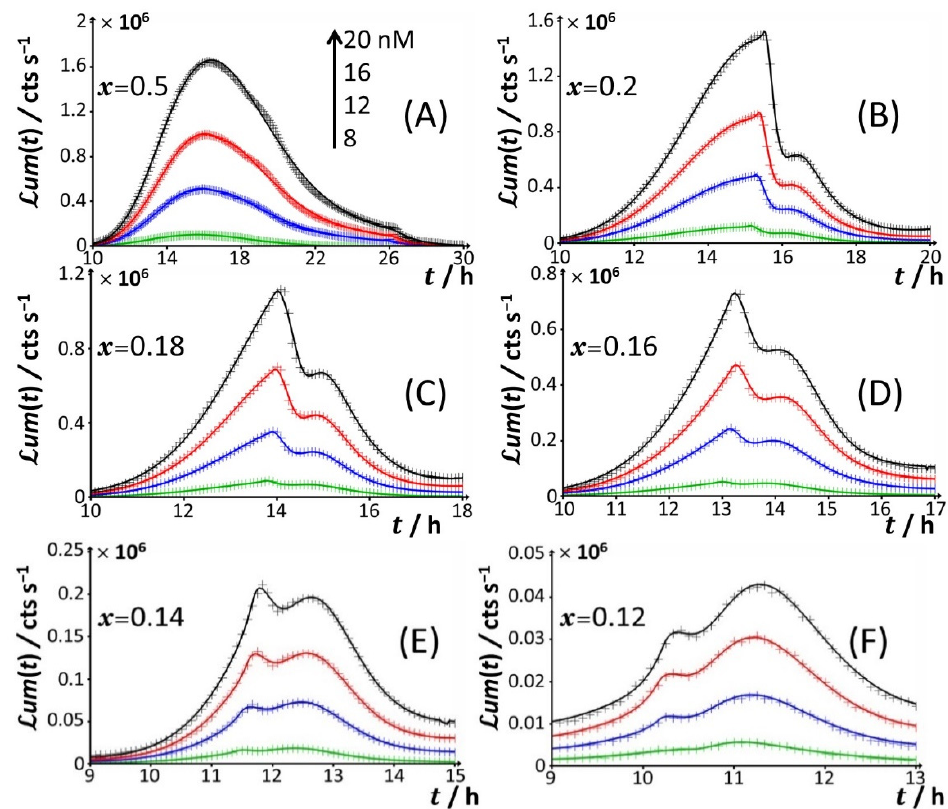
Figure 3. Time-dependence of bioluminescence ( ℒ um ( t )) measured for the Cd-responsive E. coli biosensor as a function of total Cd concentration in the range of 0–20 nM (indicated) in nGGM media supplemented with 0.1% tryptone and different concentrations of glucose and xylose (subsumed in the variable x ). Data are given for selected values of x , and they refer to the only peak P2 identified in Figures 1 and 2. The scale in Cd concentration and associated color nomenclature specified in ( A ) apply to panels ( B – F ). (+) symbols: experimental data. Lines: reconstruction on the basis of the theory outlined in Section 3. Signals were corrected by point-by-point subtraction of the corresponding cell response measured in 0 nM Cd concentration. See text for details.